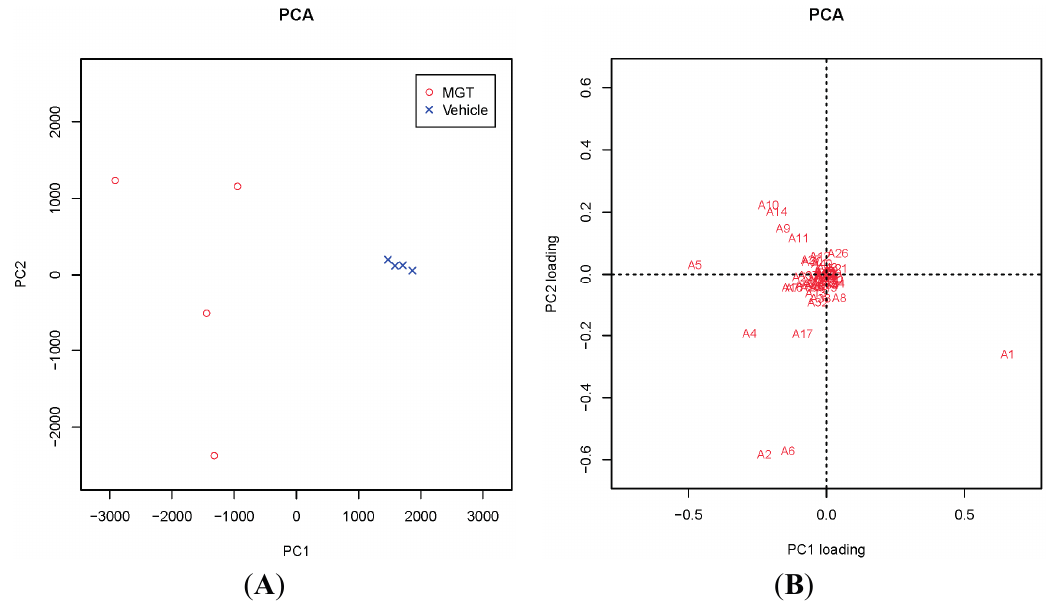
Figure 2. PCA scores and loading plots. ( A ) 2D PCA scores of DNA adducts